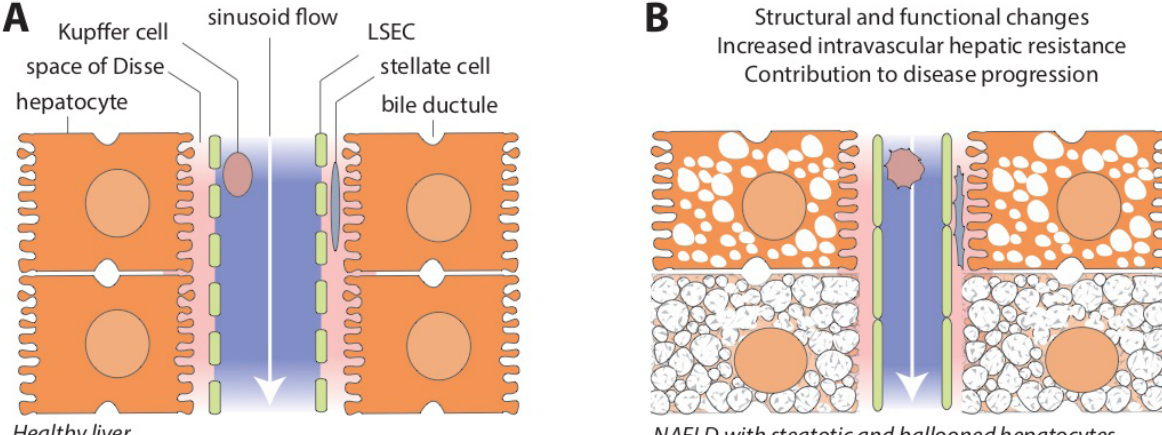
Figure 1. Hepatic sinusoids in healthy liver and in NAFLD. A. Schematic view of the liver sinusoidal space and its major cellular components. Blood flow from the portal area toward the central vein (white arrow) is unimpeded in normal conditions. Microvilli of hepatocytes face the perisinusoidal space (space of Disse, pink area), separated from the sinusoidal lumen (blue area) by the fenestrated plasma membrane of LSECs. Hepatic stellate cells reside in the space of Disse and Kupffer cells in the sinusoids; B. NAFLD is associated with structural and functional changes that may profoundly affect sinusoid homeostasis by promoting endothelial dysfunction, distorting sinusoidal microanatomy and disrupting cross-talk among various liver cells, ultimately leading to increased intravascular hepatic resistance and contributing to disease progression (see main text and Figure 2 for cellular and molecular pathways involved in this process). LSEC: liver sinusoidal endothelial